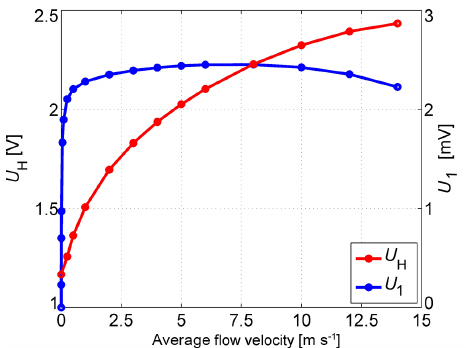
Figure 7. Simulation results (calorimetric approach) of the heater voltage U H as well as the voltage U 1 vs. the average flow ve- locity for the operating mode with constant U 2 (corresponding to T I , mean − T O , mean = 4 K ).